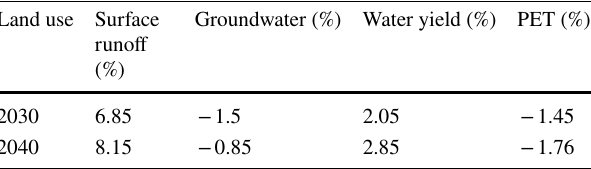
Table 10 Variation in the components of the yearly water balance under LULC